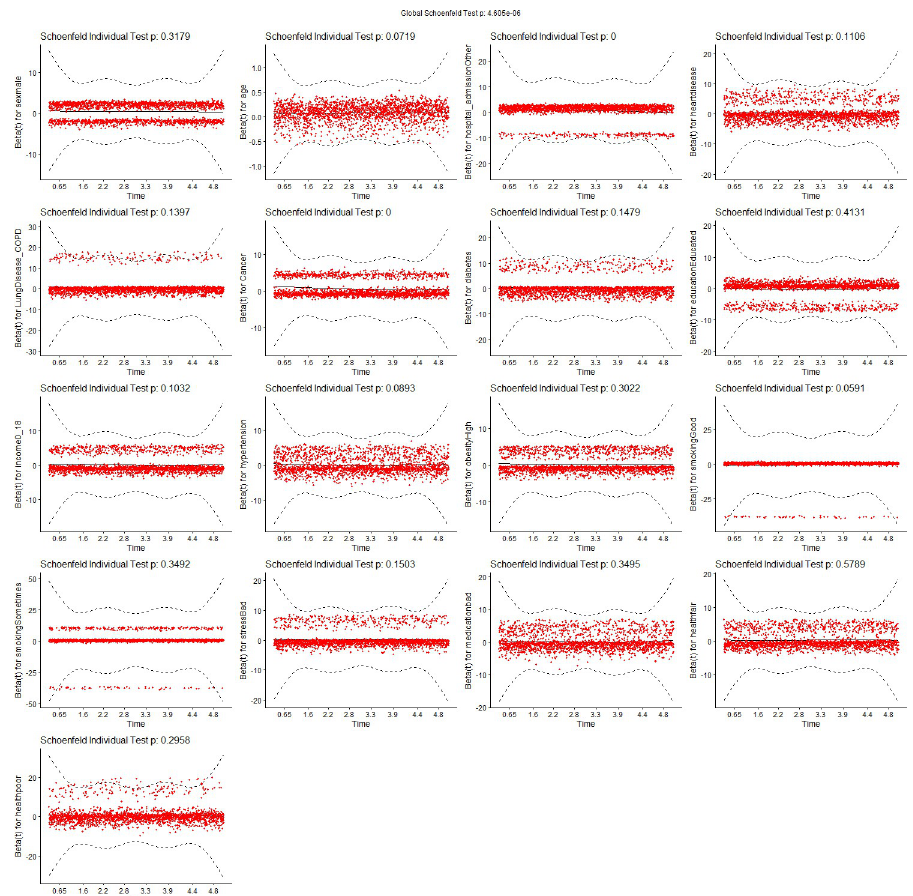
Fig 10. Feature tests for proportionality of risks: Max Model (select by